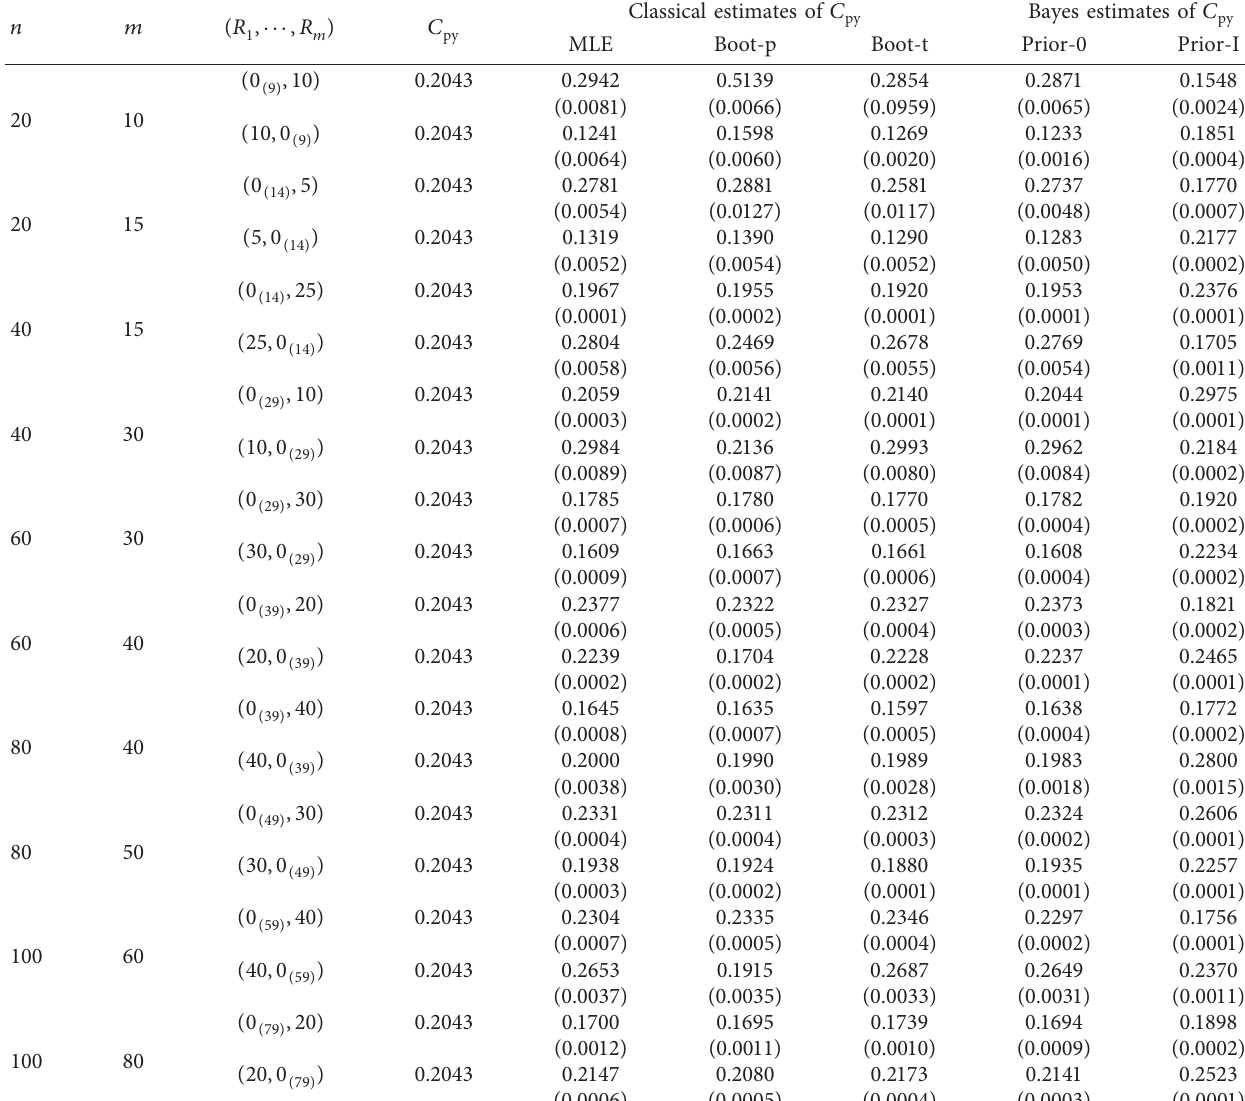
Table 5: True value of C and its classical and the Bayes estimates using different methods of estimation along with their MSEs (in py parentheses) when α � 7 . 0 , θ � 4 . 0 , and c � 0 .